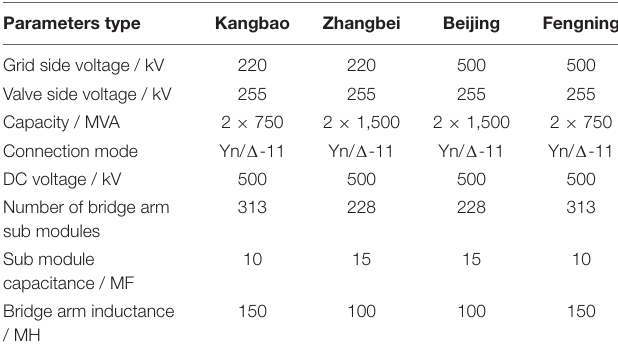
TABLE 1 | Parameters of the zhangbei multi terminal flexible dc